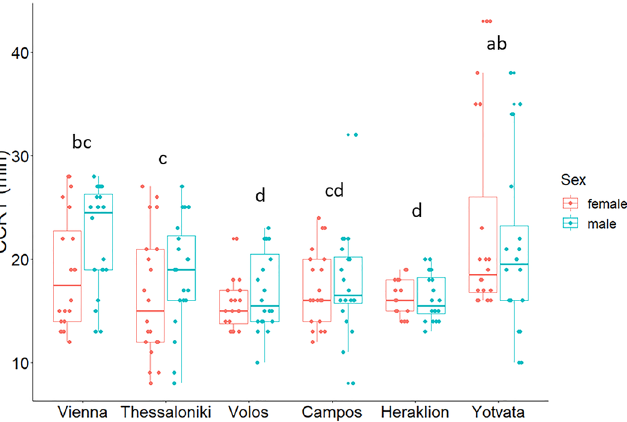
Figure 3. Chill coma recovery time (minutes) of males and females from the six Ceratitis capitata populations. Boxplots include the median, the 1st and 3rd quartile; whiskers indicate the highest/lowest value inside the interval defined by ± the 1.5-fold interquartile range from the 1st/3rd quartile. Populations labeled with the same lower case letter are not significantly different from each other (Benjamini-Hochberg (B-H) correction was used to adjust for multiple comparisons: p > 0.05). Sex was not significant (Cox Regression analysis, p = 0.142). N = 20 males and 20 females per